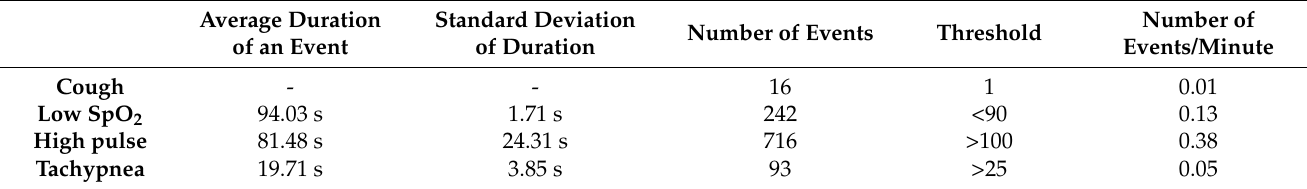
Table 3. Events recorded during the whole study